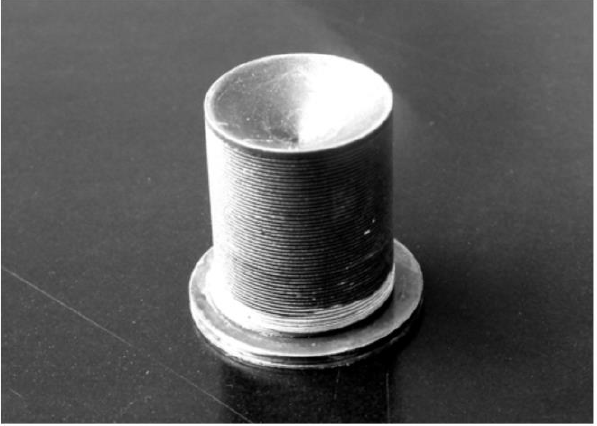
Figure 7. High temperature ultrasonic transducer with an integral concaved